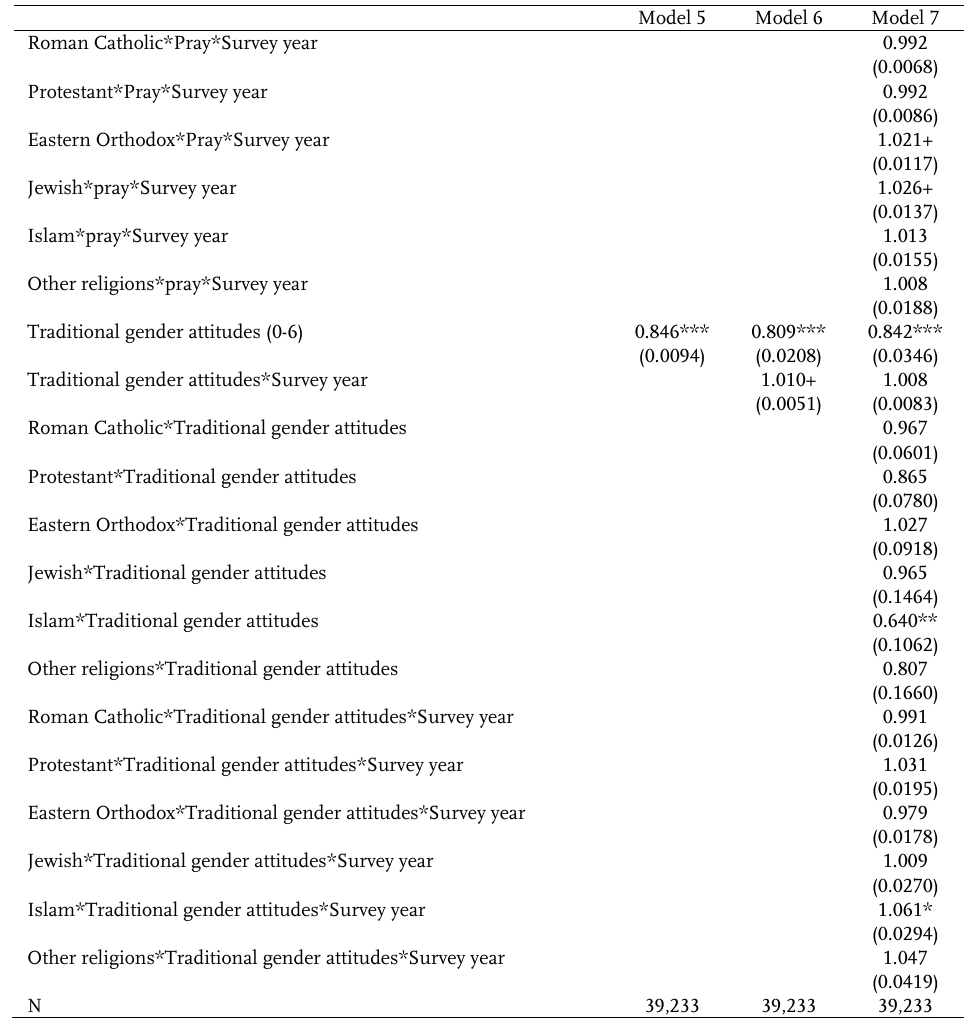
Table A.2 : Odd ratios role of religiosity and gender role attitudes on employment likelihood of women in different religion over time (Model 1, 2, 3 and 4 are in Table 4)